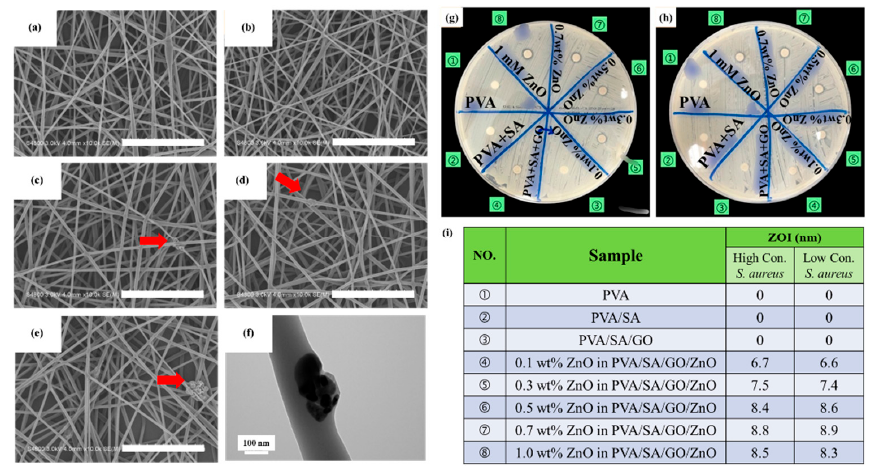
Figure 4. The SEM images of PVA/SA/GO/ZnO nanofibers were prepared by adjusting the amount of ZnO addition: ( a ) 0.1 wt%, ( b ) 0.3 wt%, ( c ) 0.5 wt%, ( d ) 0.7 wt%, with ( e ) 1.0 wt%. ( f ) the magnification SEM image of PVA/SA/GO/ZnO nanofibers with 1 wt% ZnO NPs addition. The antibacterial results of PVA/SA/GO/ZnO antibacterial solution, in which the differences of ( g ) high concentration S. aureus and ( h ) low concentration S. aureus were compared. ( i ) The zones of inhibition (ZOI) of PVA/SA/GO/ZnO antibacterial solution against S. aureus . (The scale bar in the SEM image is 5 μ m).